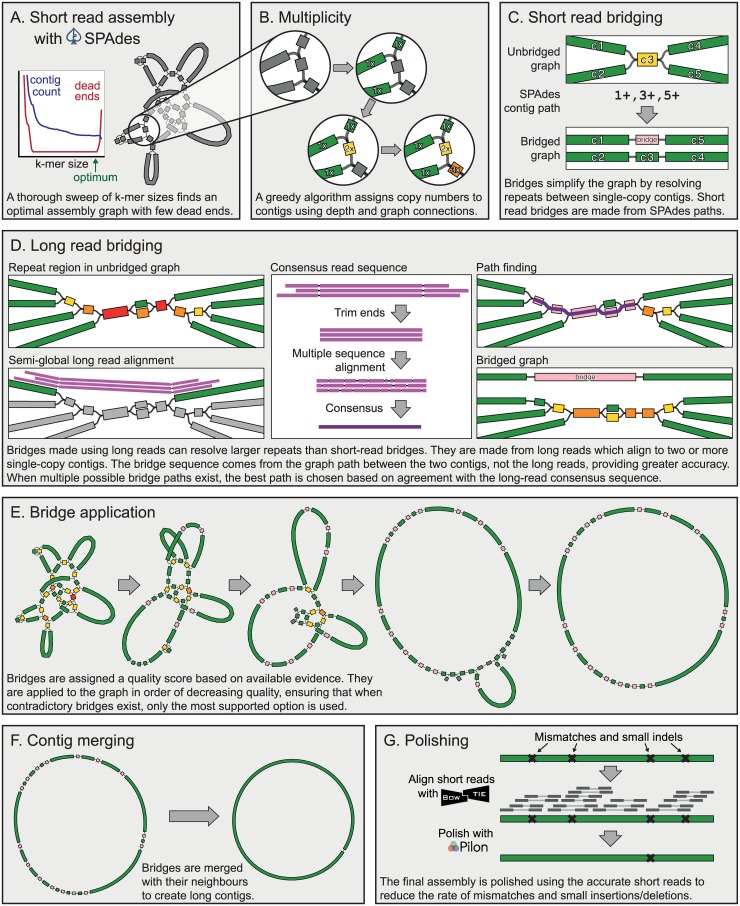
Key steps in the Unicycler pipeline.